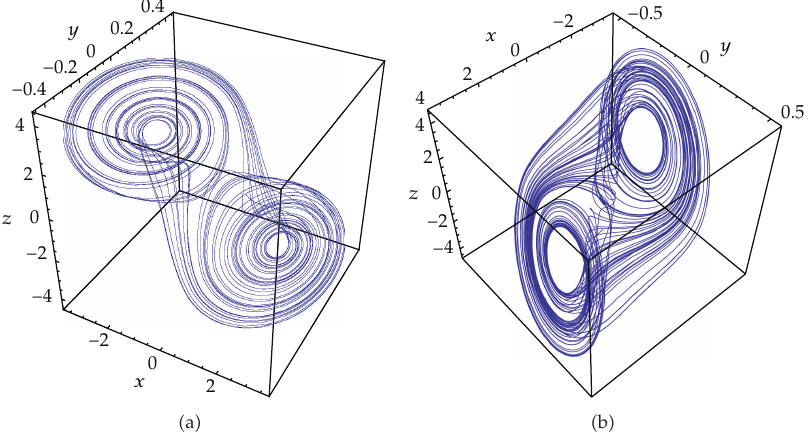
Figure 2: Phase plot of Chua’s chaotic attractor in the x - y - z space: (cid:3) a (cid:4) q 1 (cid:7) q 2 (cid:7) 0 . 98, q 3 (cid:7) 0 . 94, α (cid:7) 10 . 1911, (cid:3) b (cid:4) q (cid:7) q (cid:7) 0 . 87, q (cid:7) 0 . 88, α (cid:7) 9 . 1 3 2